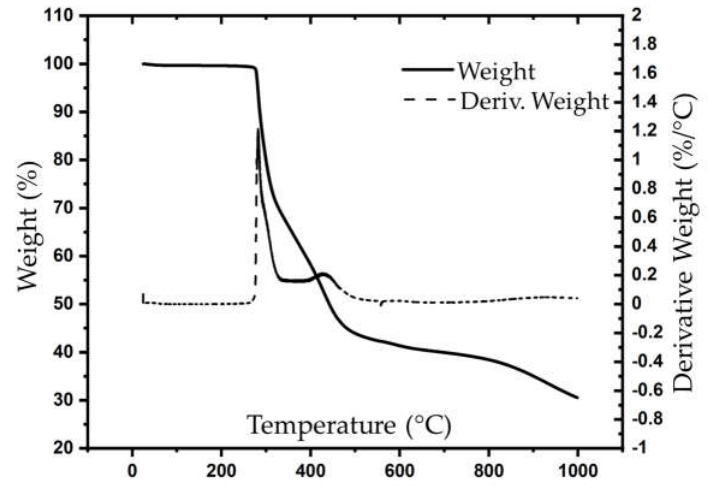
Figure 5. Thermogravimetric analysis of as-received PAN.